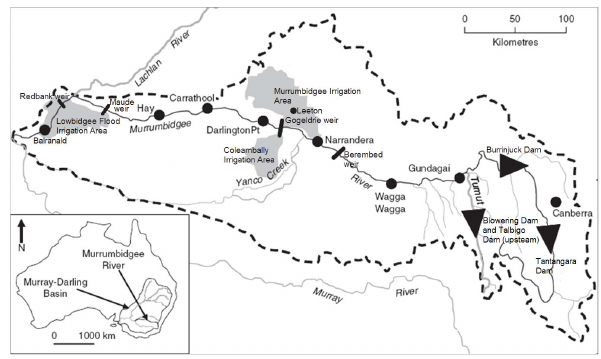
Fig. 1. Murrumbidgee Catchment within the Murray–Darling Basin (adapted from: Frazier and Page, 2006). The Murrumbidgee Irri- gation Area incorporates the the Yanco Irrigation Area, Mirrool Ir- rigation Area, Wah Wah Irrigation District, Benerembah Irrigation District, and Tabbita Irrigation District. In the figure dots or filled circles refer to towns, filled triangles to dams and bars to